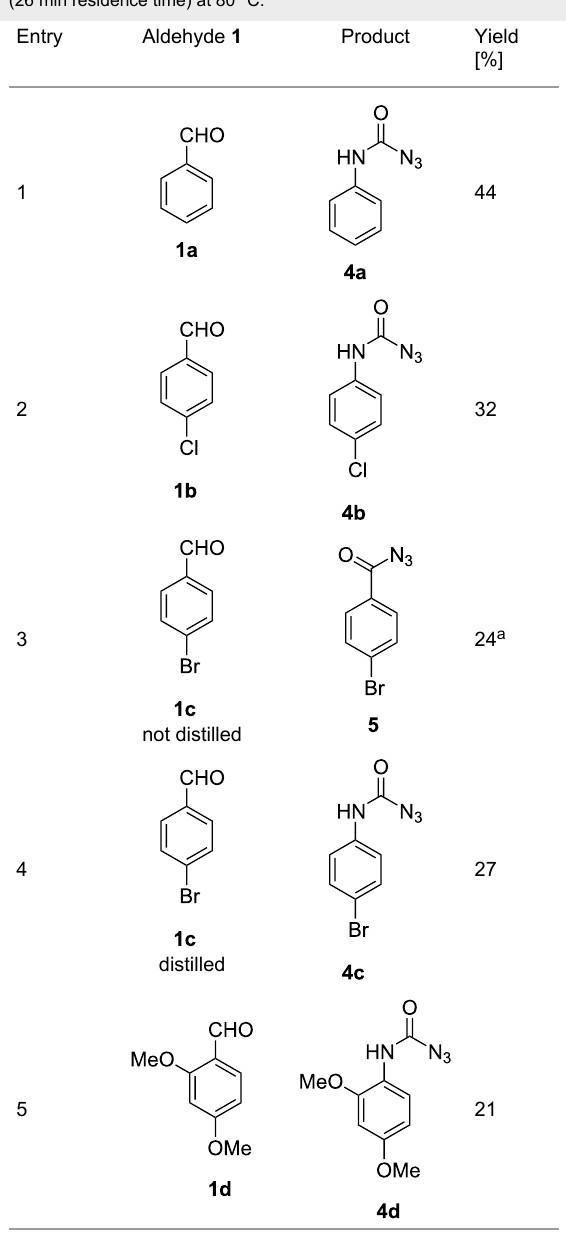
Table 1: Products and yields in the addition of iodine azide to alde- hydes performed in a tubing microreactor at a flow rate of 7.5 µL/min (26 min residence time) at 80